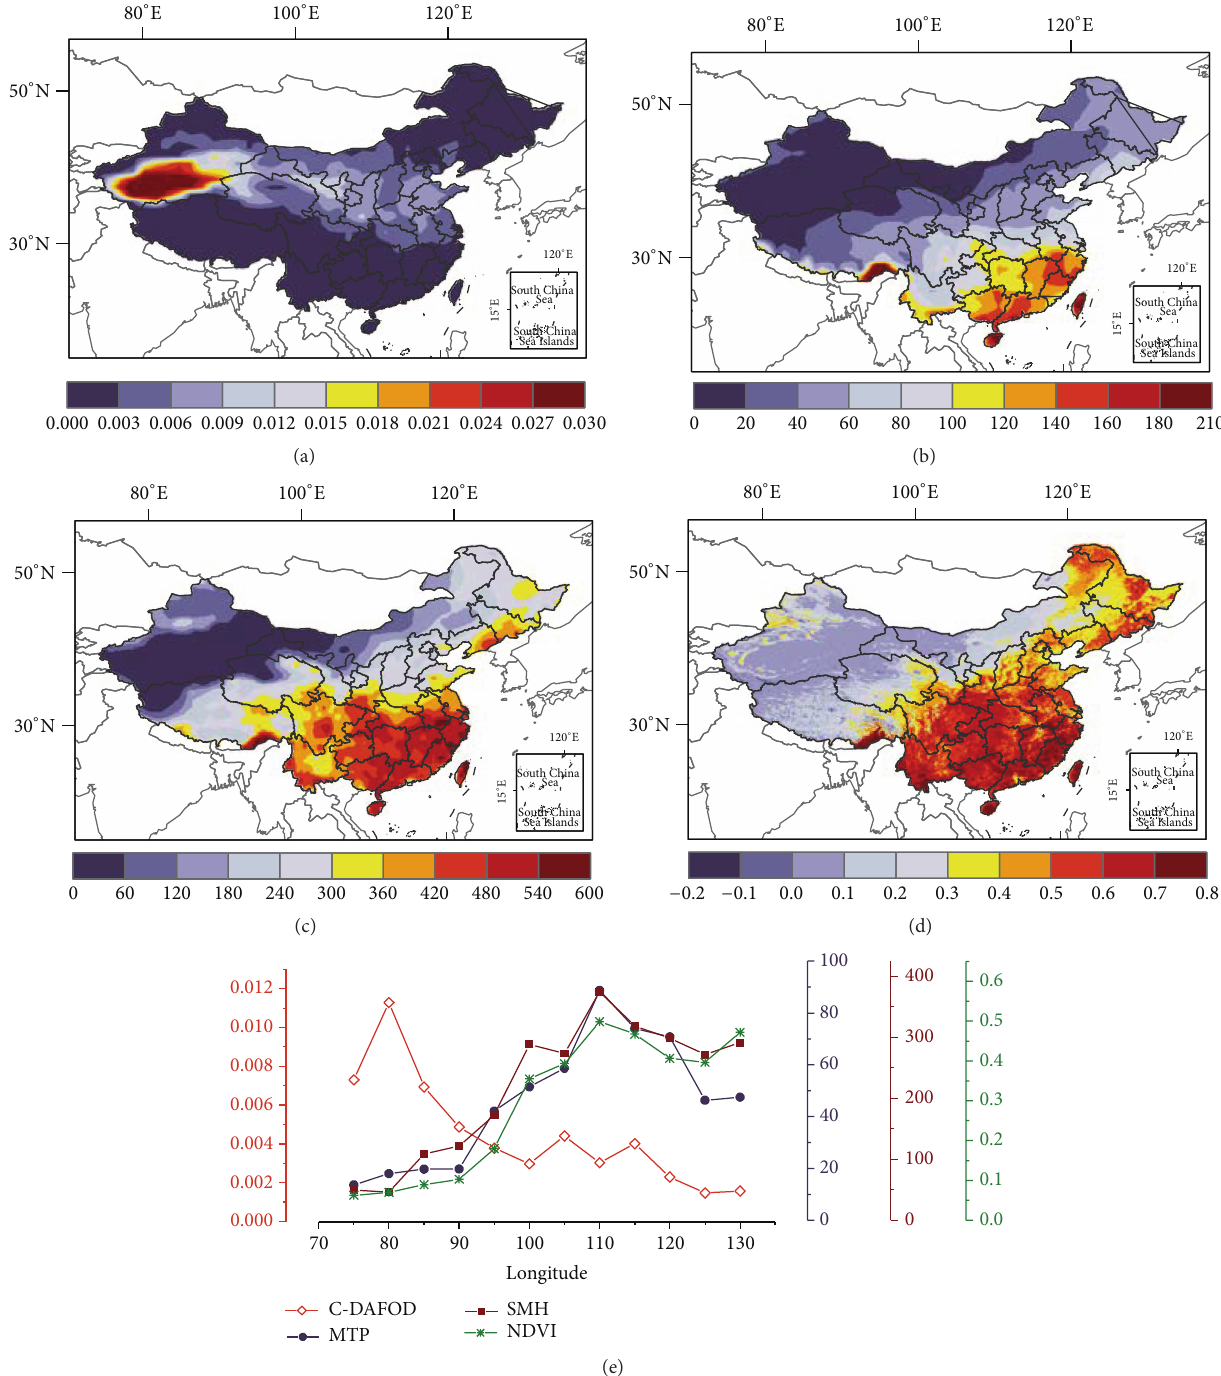
Figure 2: Spatial distribution maps of the multiyear (2007–2014) averaged (a) C-DAFOD, (b) MTP, (c) SMH, and (d) NDVI over China. (e) Longitudinal variation of the latitude averaged values for the previous four